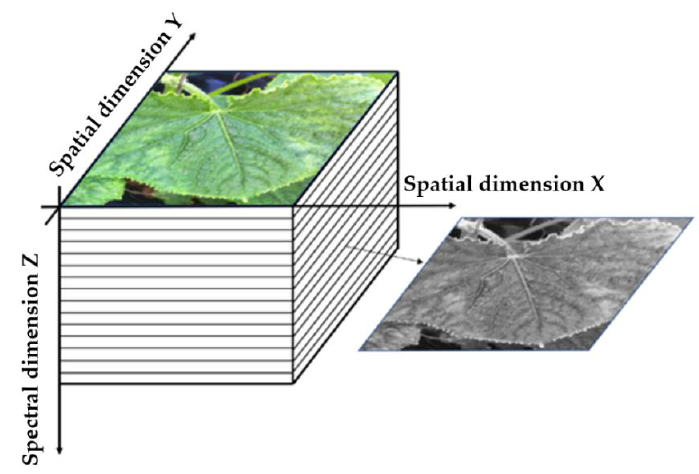
Figure 2. Structure of a hyperspectral image data cube of a cucumber leaf.